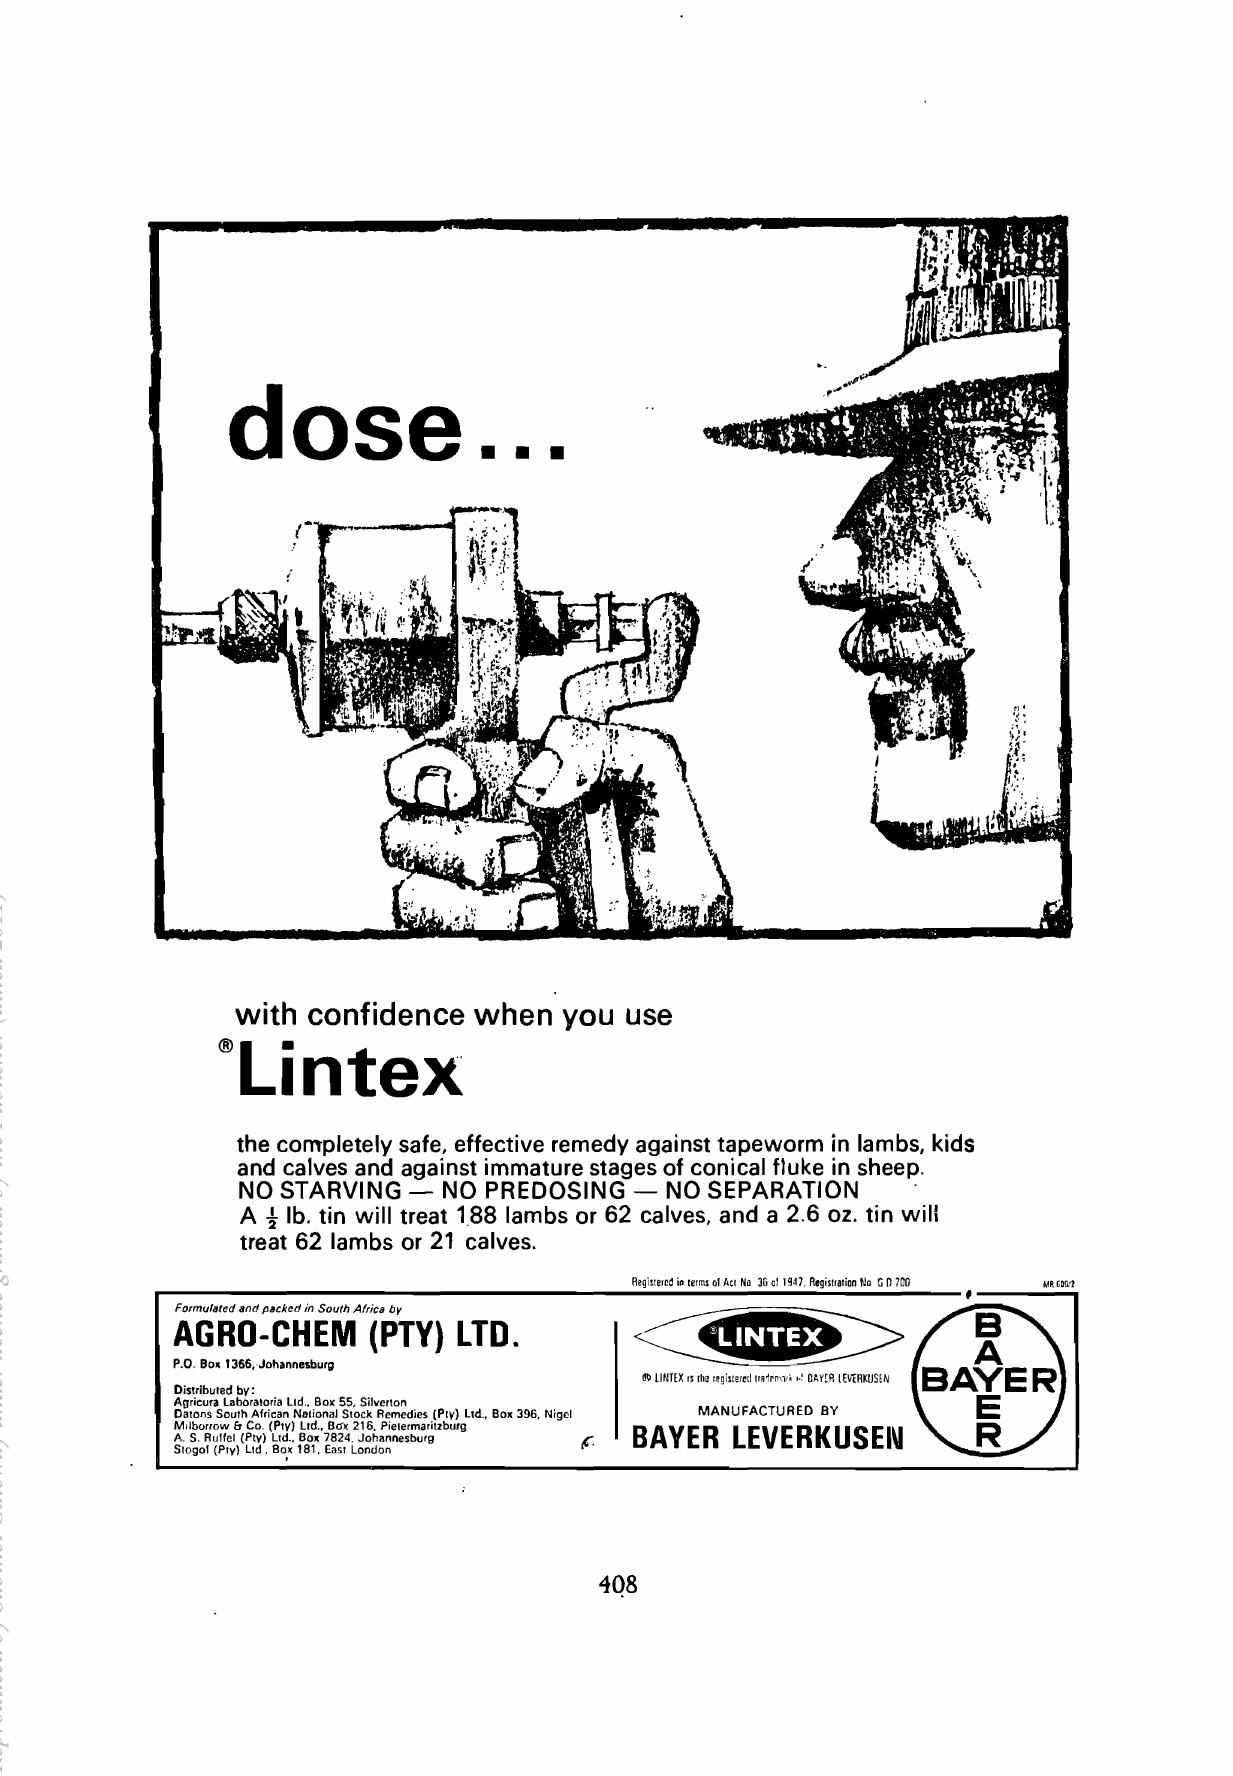
the completely safe, effective remedy against tapeworm in lambs, kids and calves and against immature stages of conical fluke in sheep. NO STARVING - NO PREDOSING - NO SEPARATION A ~ lb. tin will treat 188 lambs or 62 calves, and a 2.6 oz. tin will treat 62 lambs or 21